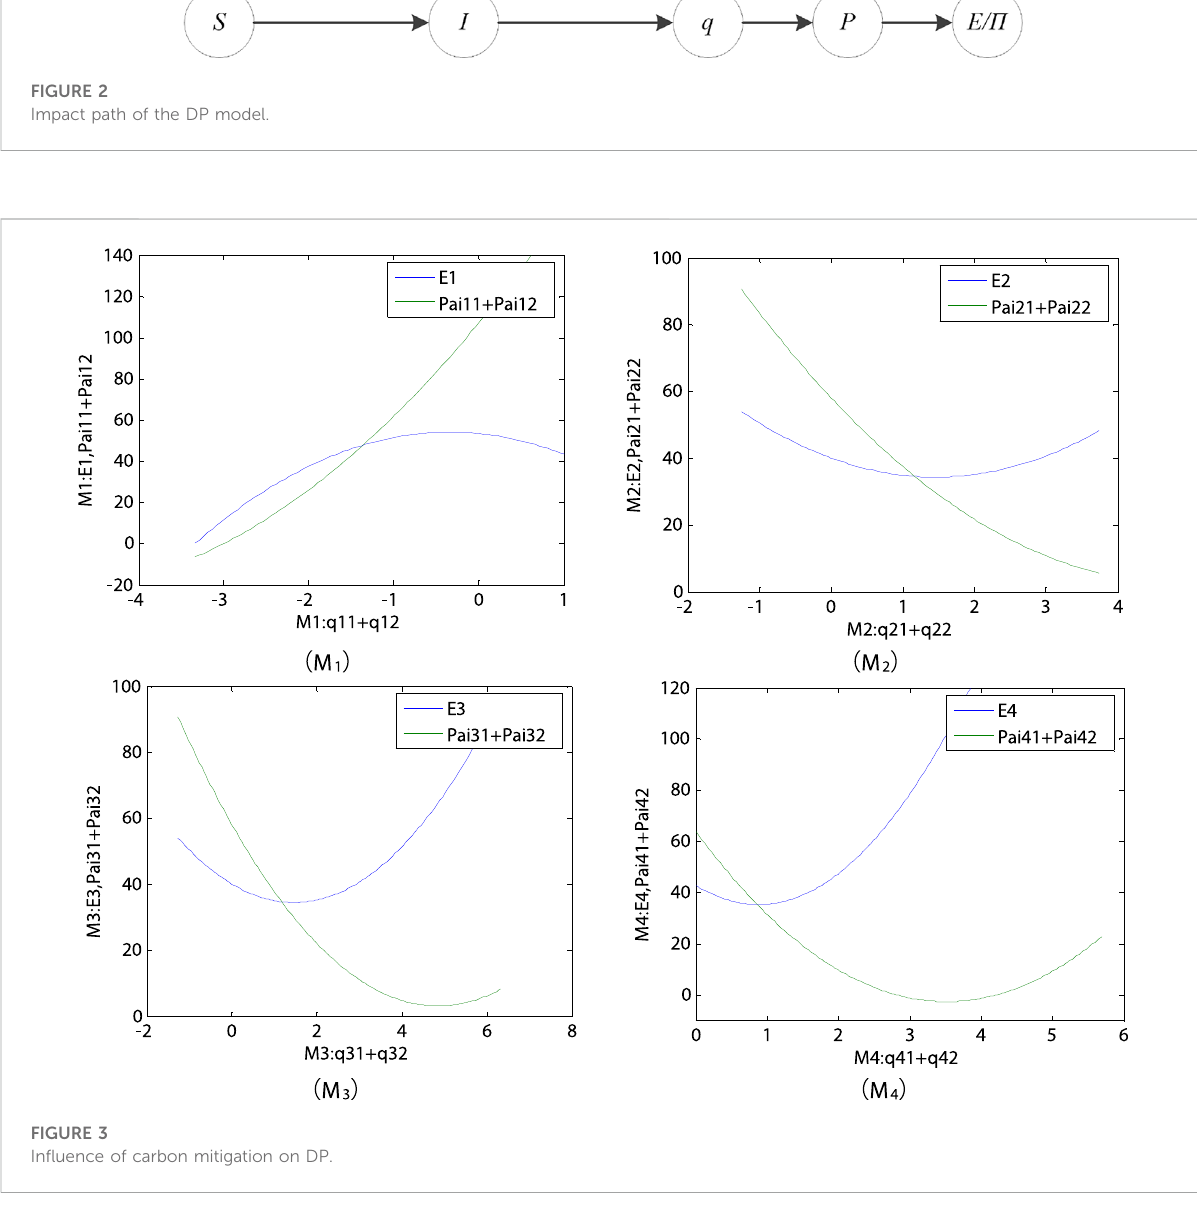
FIGURE 3 In fl uence of carbon mitigation on